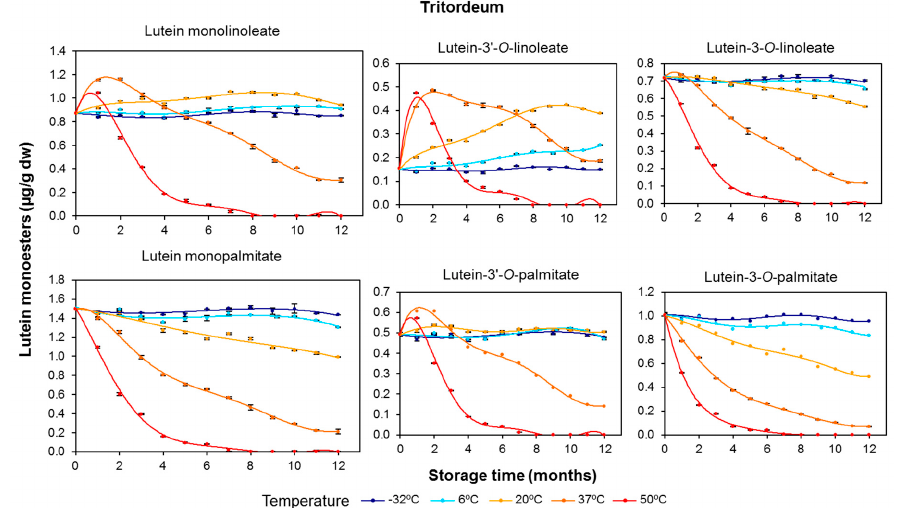
Figure 5 Figure 5. Evolution of the monoesterified lutein ( µ g/g dry weight), including the regioisomers, in tritordeum (HT621 advanced line) whole-grain flours during long-term storage under temperature controlled conditions ( − 32, 6, 20, 37 and 50 ◦ C). The values shown are the mean and standard error ( n = 5 for the starting sample, n = 3 for the rest of the samples).